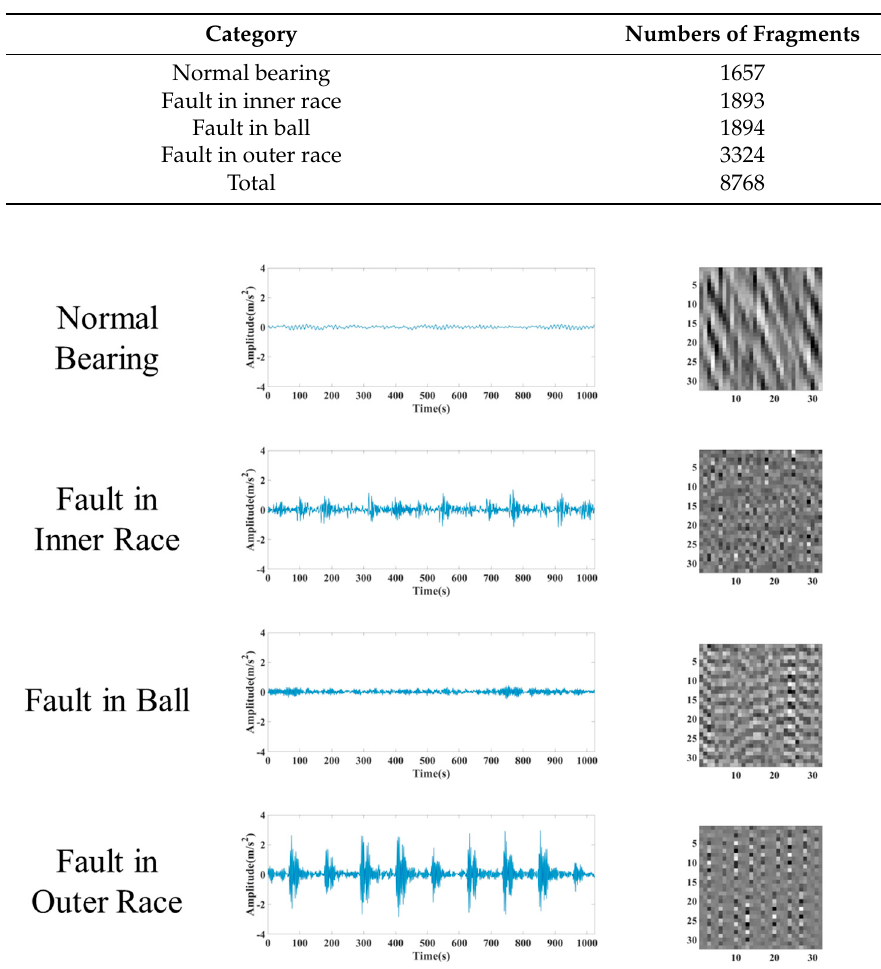
Figure 7. A processed fragment and the corresponding images in each